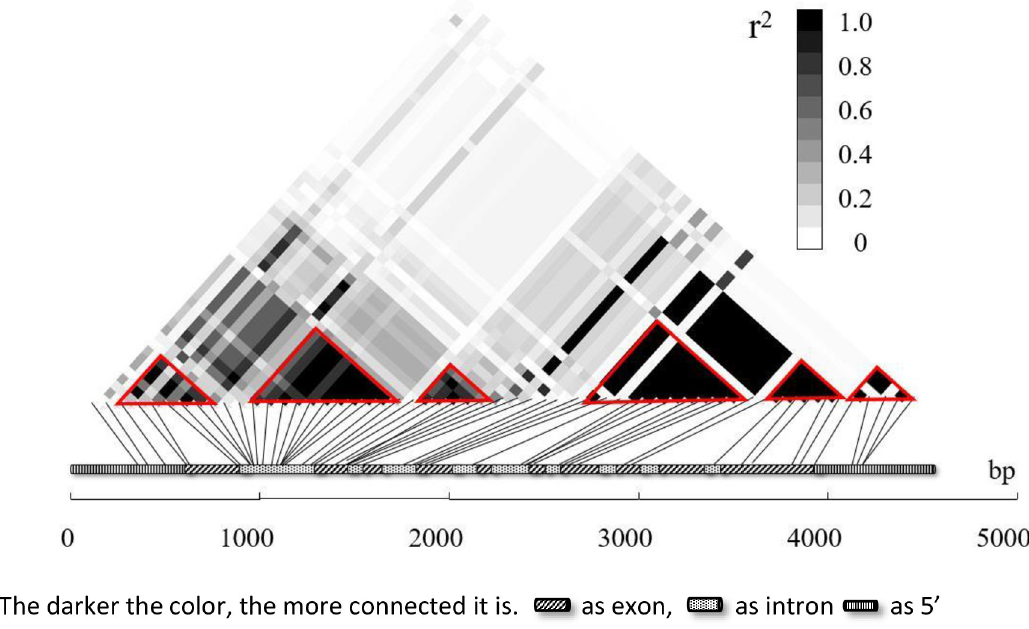
Fig 5. LD matrix diagram of the PeTPS-(-)Apin